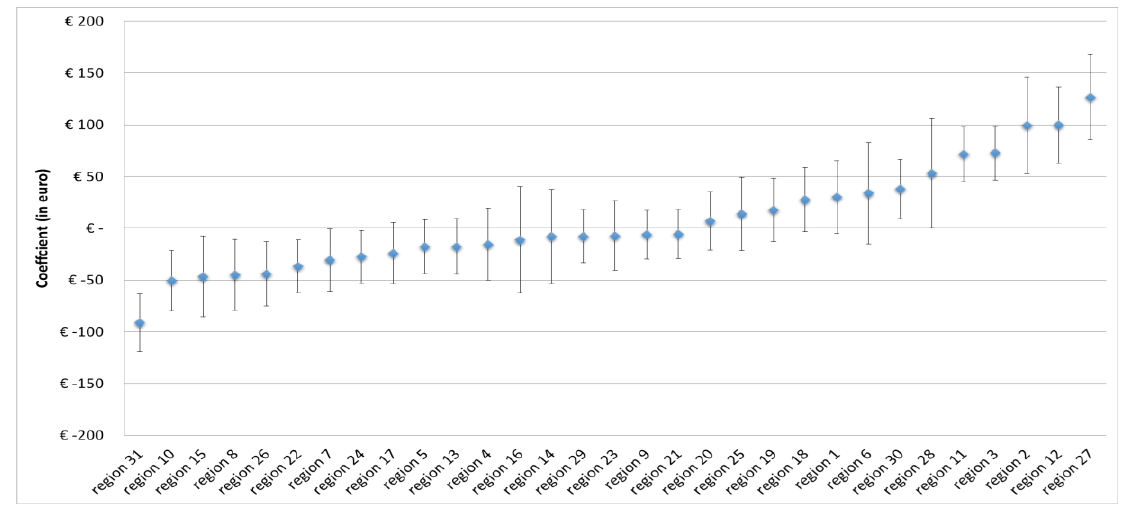
Figure 4.2: Linear regression model for the average intensity of care younger than